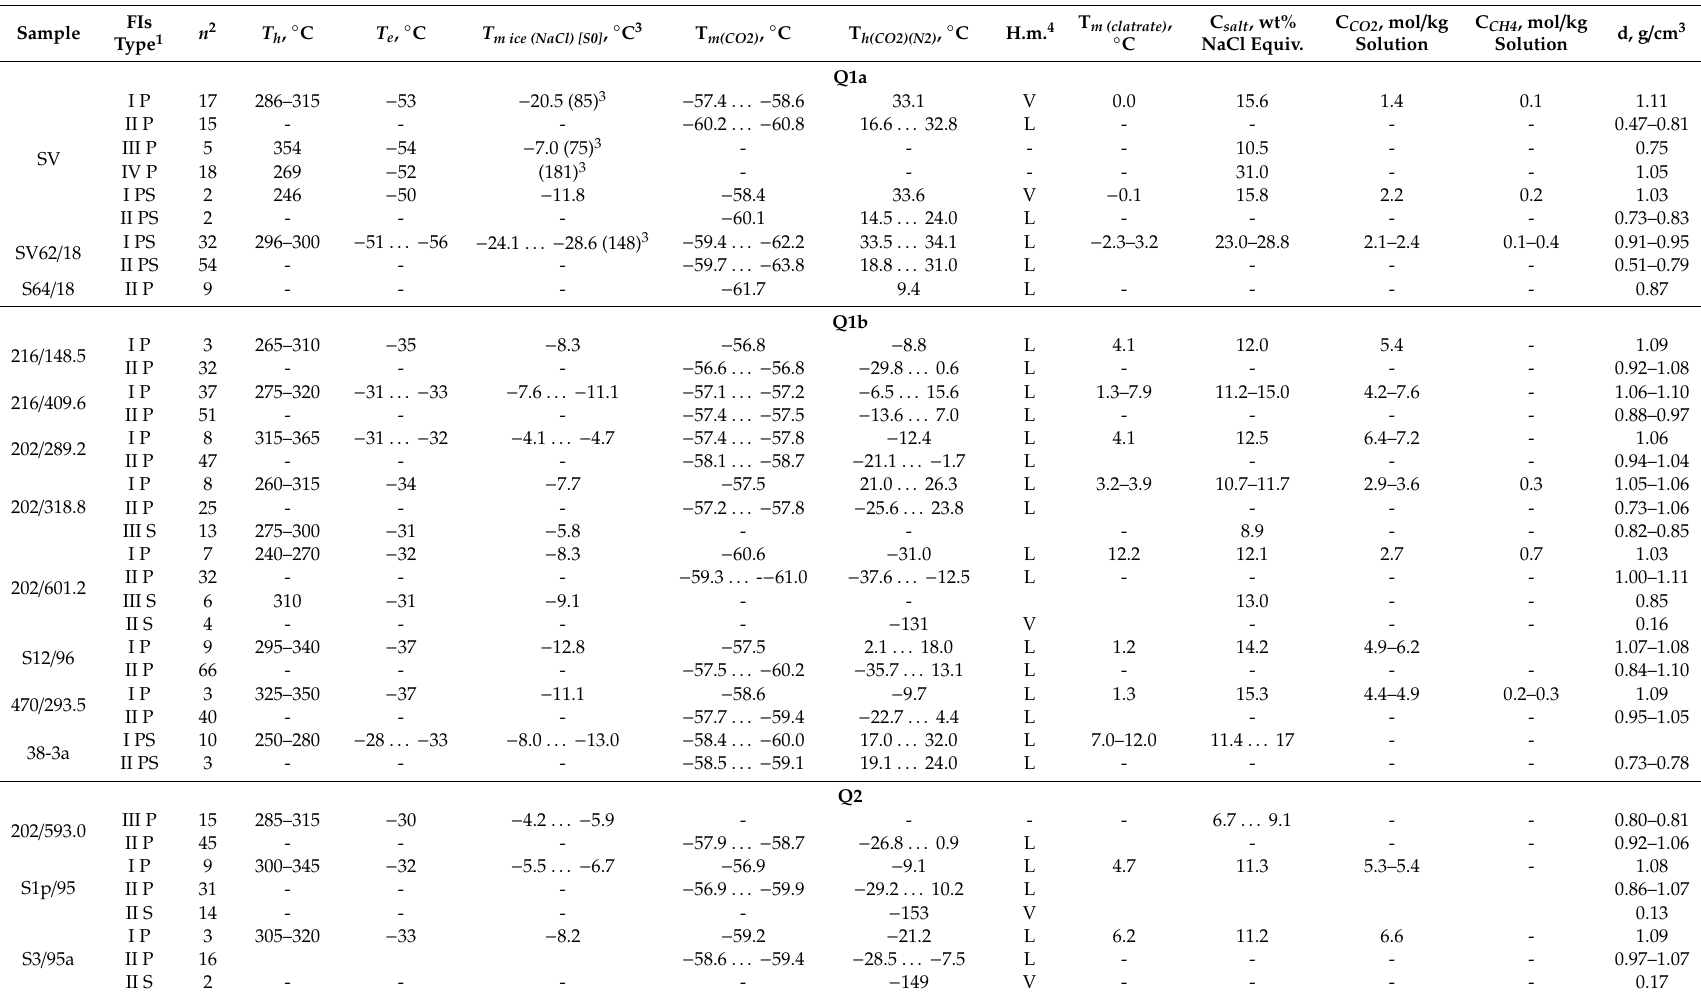
Table 1. Microthermometric study of individual fluid inclusions (FIs) in quartz from the Svetlinsk